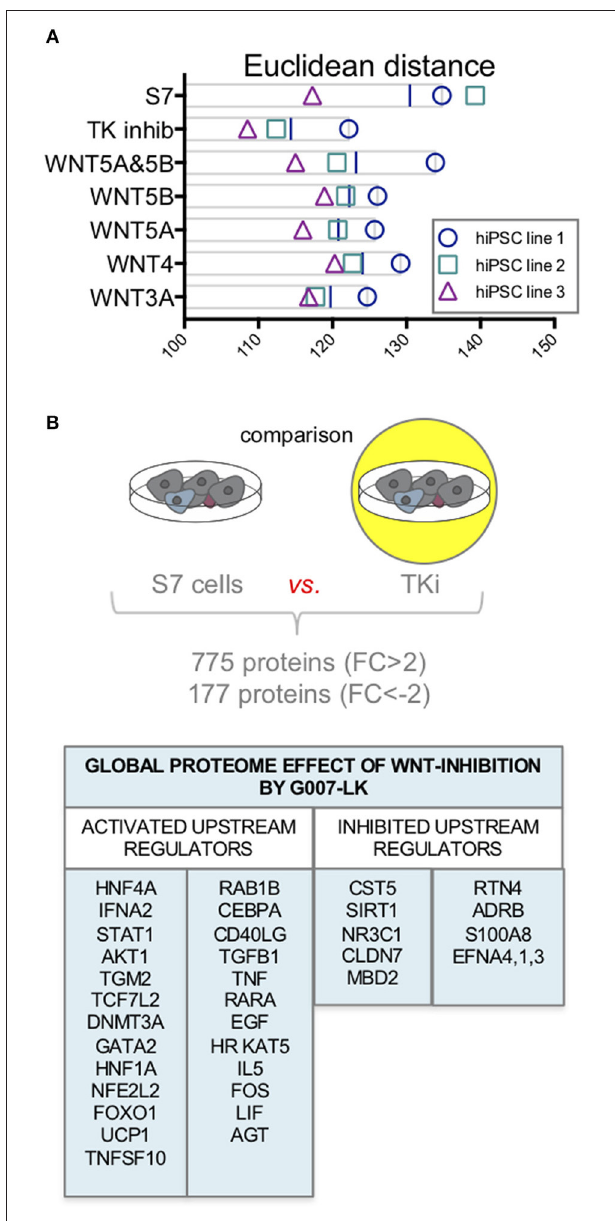
FIGURE 5 | Proteome changes in response to Wnt-modulation of S7 cells. (A) Euclidean distance on log2 scale between S7 cells and the different Wnt-modulated S7 cell conditions and adult human islets. Of the three cell lines ( n = 3, biological triplicates), TKi had the lowest distance measured between TKi-treated S7 cells vs. adult human islets. (B) Using quantitative proteomics data from one of the cell lines we examined the global proteome effect of endogenous Wnt inhibition by TKi on S7 cells resulting in increased abundance of 755 proteins (FC > 2) and decreased abundance of 177 proteins (FC < − 2). The IPA software predicted upstream regulators protein signature based on these differentially regulated proteins.